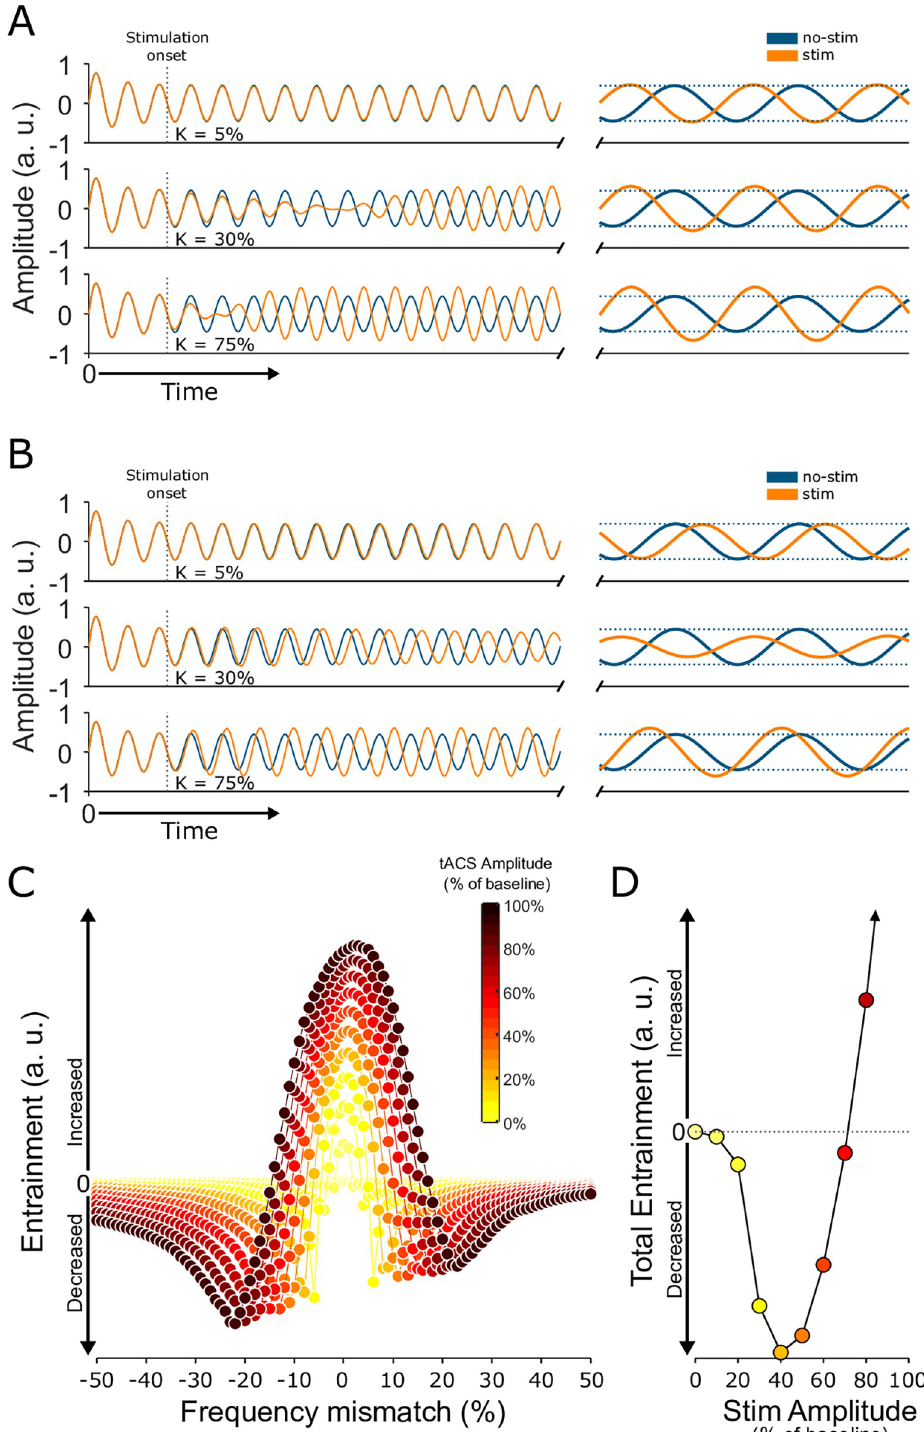
Fig 4. A simple oscillator model replicates these results. (A) Stimulating the Stuart–Landau model at the same frequency tends to increase entrainment and shift phase. The model’s output, x(t) , is shown during a no-stimulation condition (blue) and during the application of tACS (yellow) at low (top), medium (middle), and high (bottom) stimulation intensities. Dotted lines indicate oscillation’s amplitude in the absence of stimulation. The other component of the model, y(t) , is simply a phase-shifted version of x(t) and shows the same pattern of effects, as